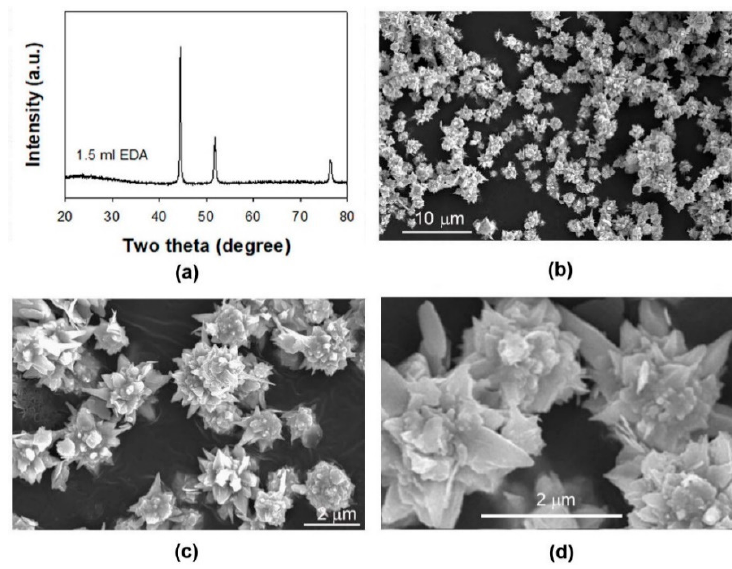
Figure 4. XRD patterns ( a ) and SEM images ( b – d ) of the product formed in 200 mL of 15 M NaOH solution containing 1.5 mL EDA. Reaction duration is 6 h.